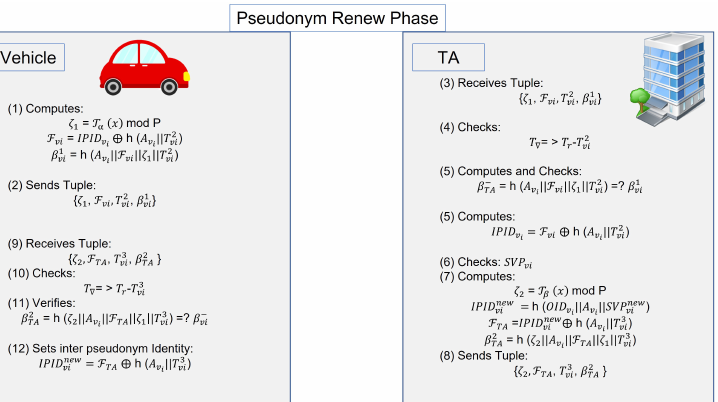
Figure 4. Pseudonym Renew